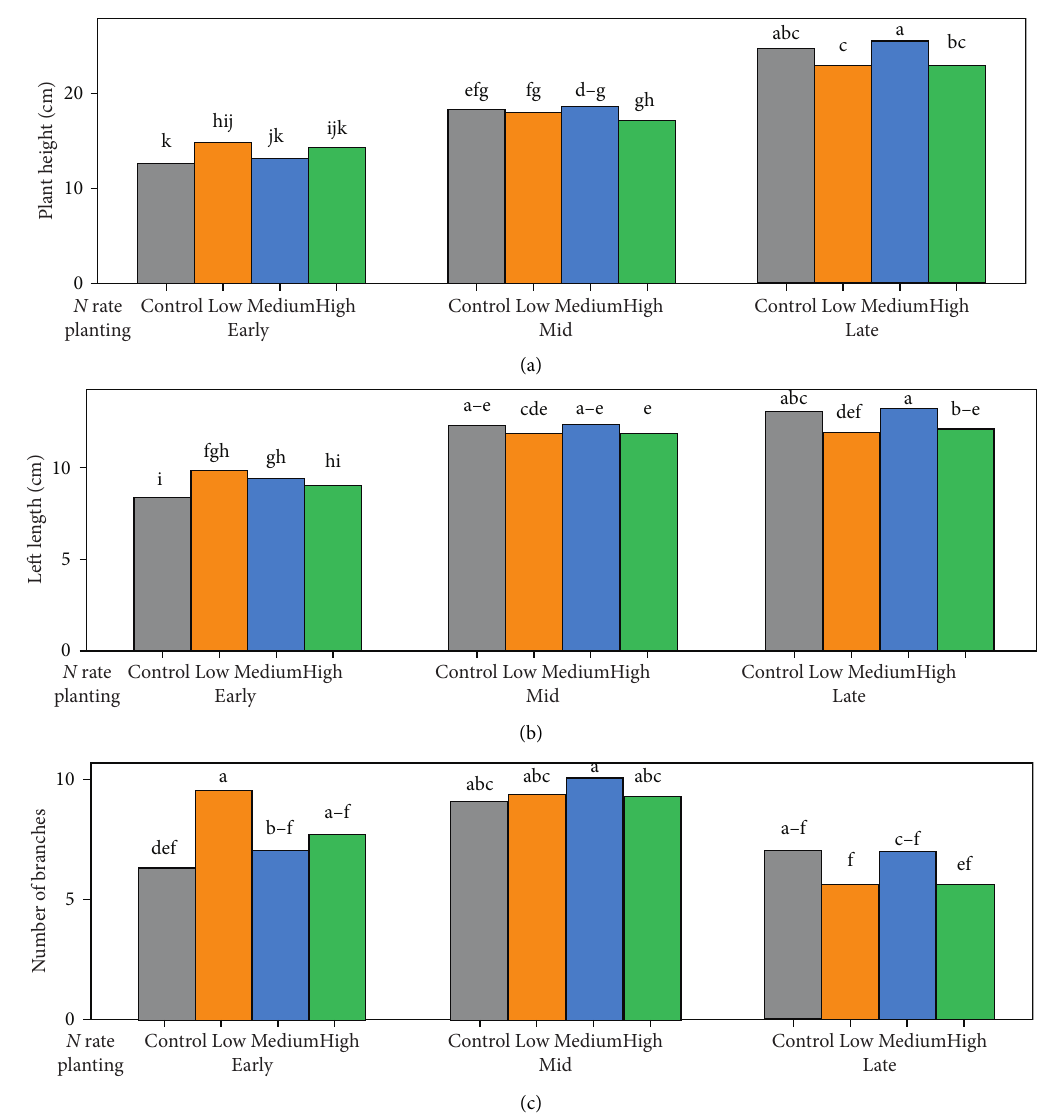
Figure 2: Interaction effects of planting time and N rate on plant height (cm), leaf length (cm), and stem diameter (mm). Means sharing the same letter are not significantly different at p < 0 .